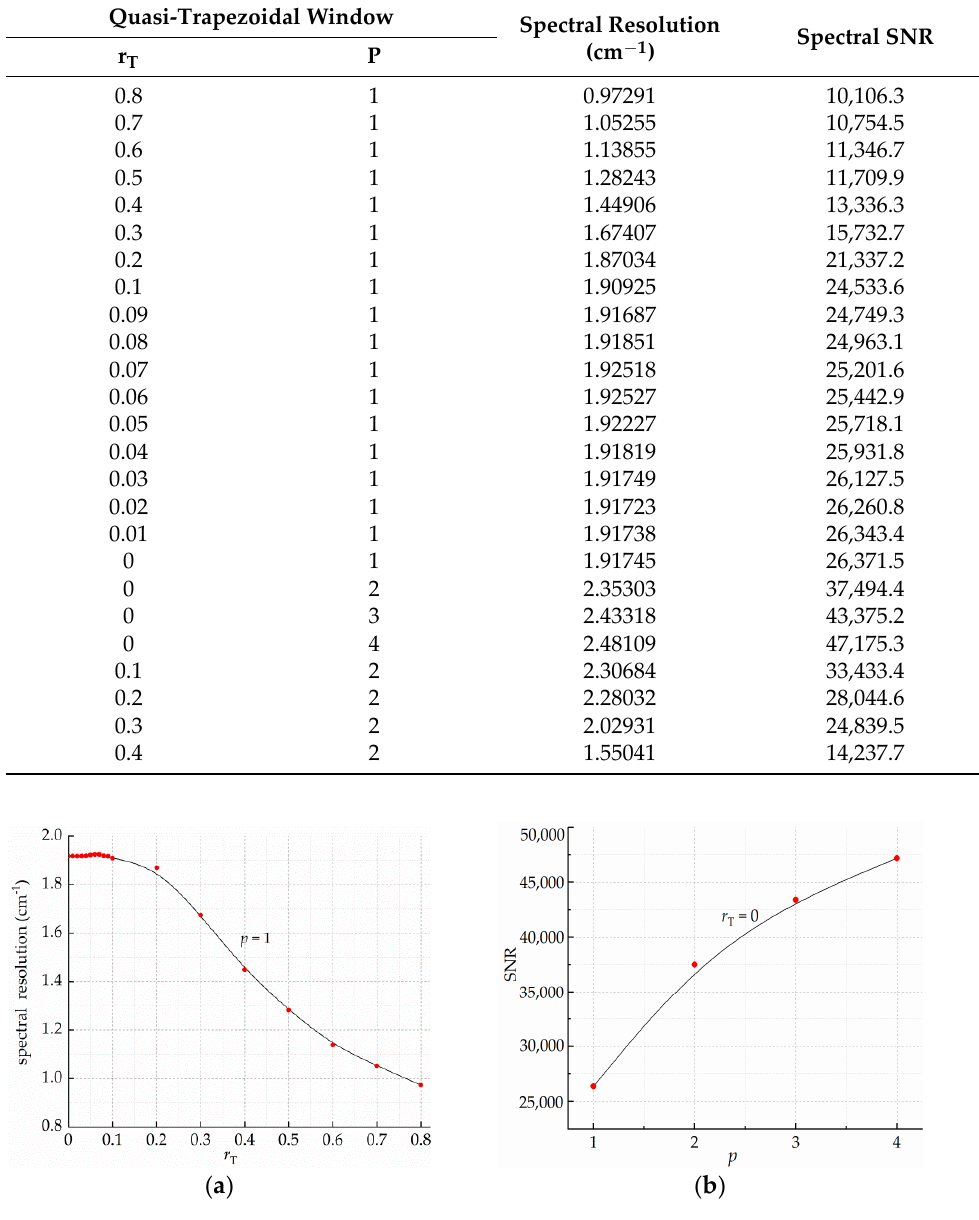
Figure 5. ( a ) Trend plots of spectral resolution as a function of r T ; ( b ) trend plots of spectral SNR as a function of p